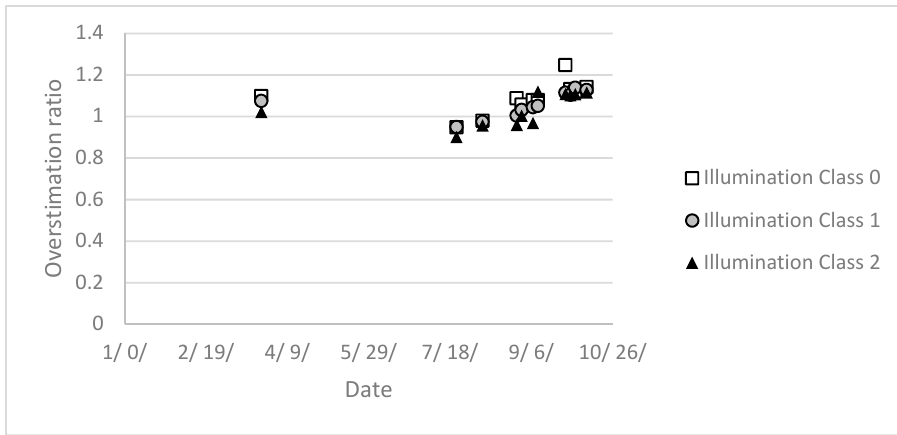
Figure 11. Area errors on selected pixels.